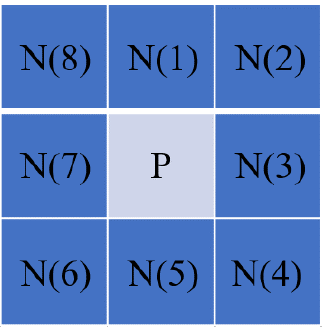
Figure 1. Location of N(1–8) around